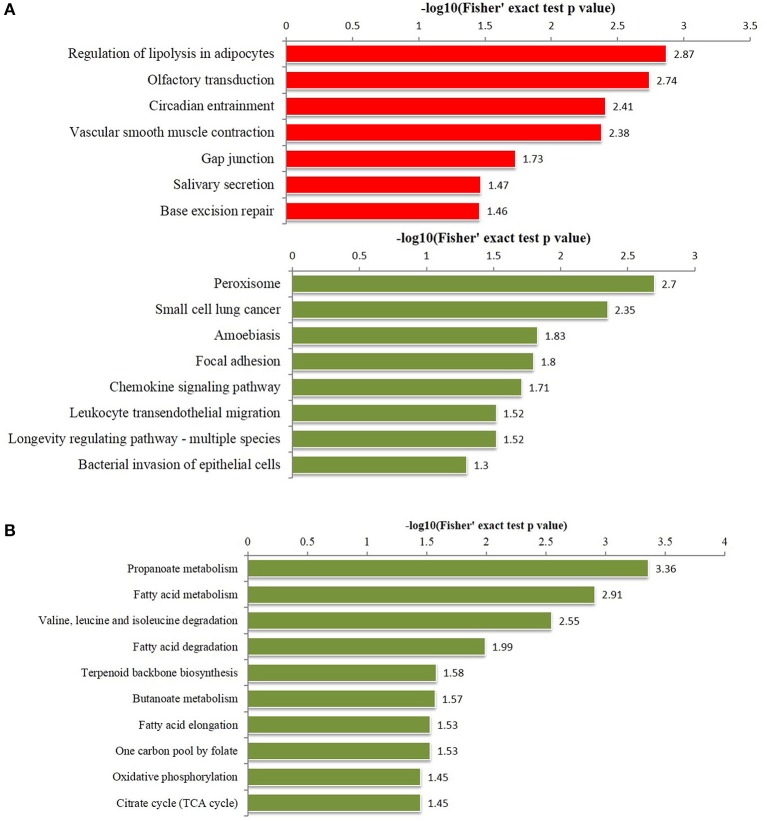
Enriched pathways analysis of differentially phosphorylated and acetylated proteins (all p < 0.05). (A) phosphorylation. (B) Acetylation. Red, Pathways terms of proteins for which the modification was upregulated. Green, Pathways terms of proteins for which the modification was downregulated.